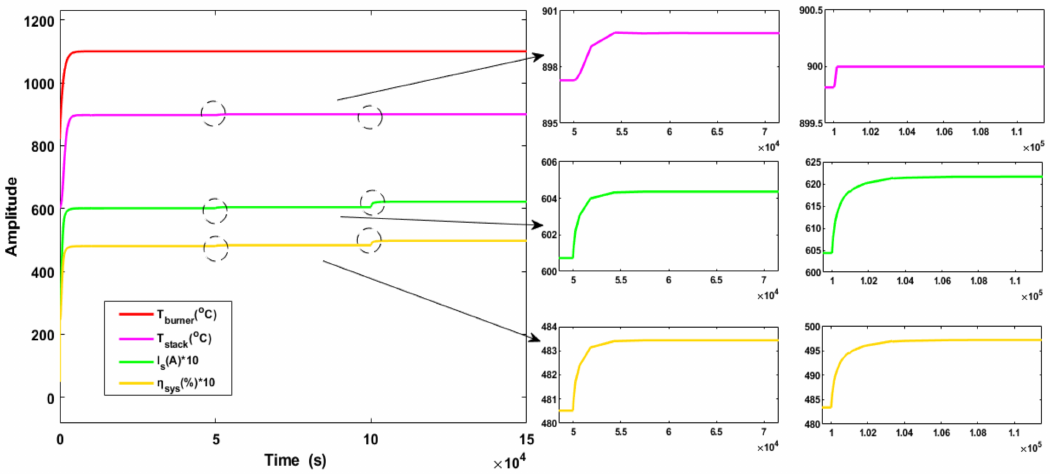
Figure 11. The system performance parameter curve caused by the imbalance of afterburner inlet air